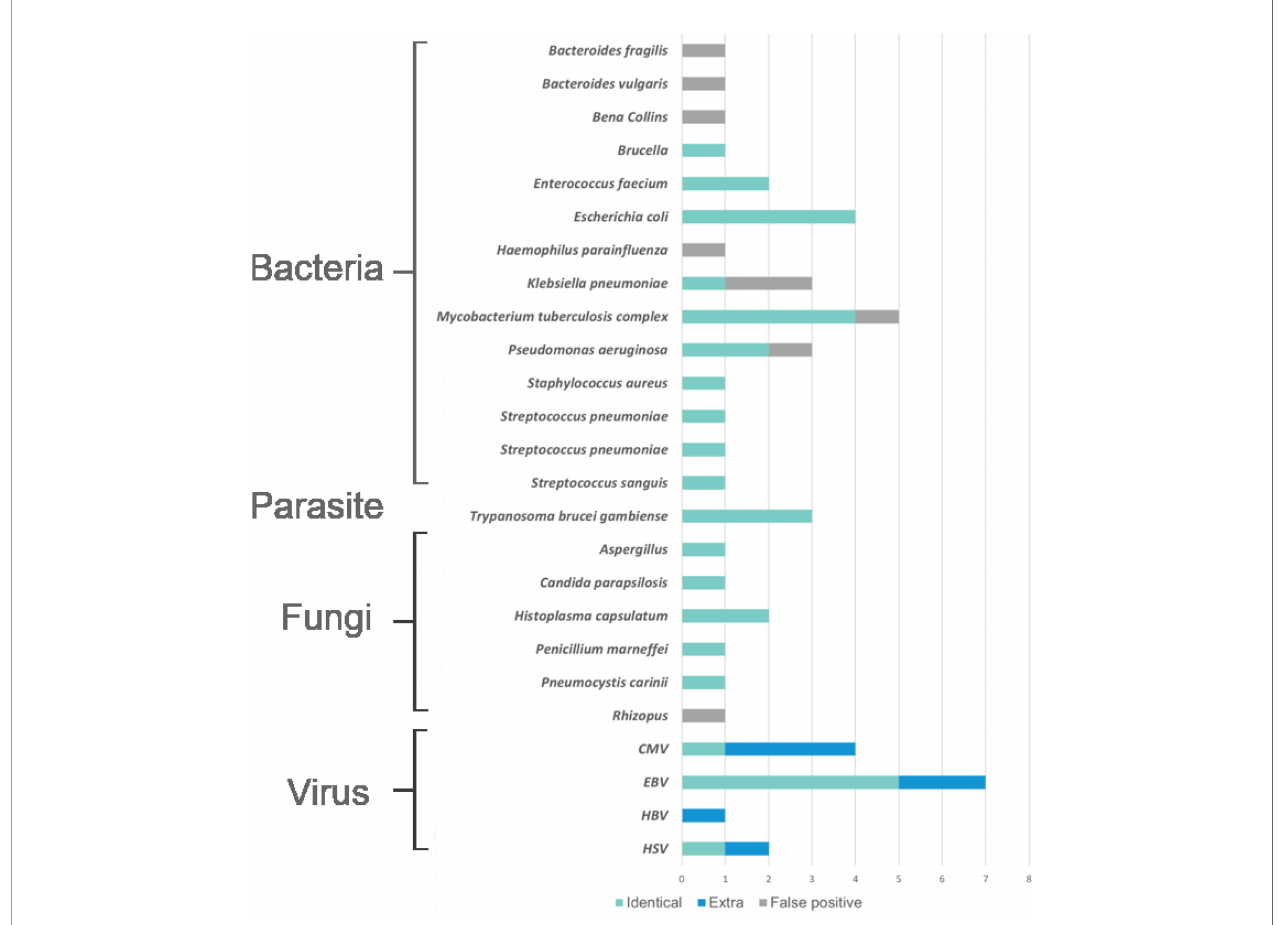
FIGURE 2 | The distribution of pathogens detected by metagenomic next generation sequencing (mNGS). The distributions were divided into four parts, namely, bacteria, parasites, fungi, and viruses, and each part consisted of identical detection (the blue), extra detection (the green), and false positive detection (the